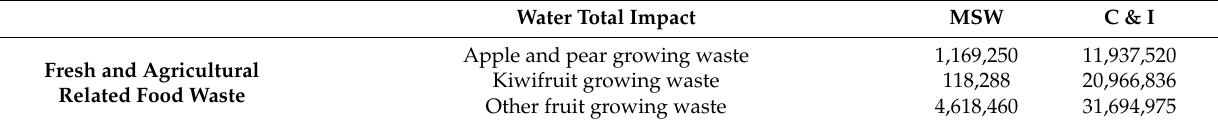
Table 4. Total water embodied (M3) in food waste generated in New Zealand in 2011.